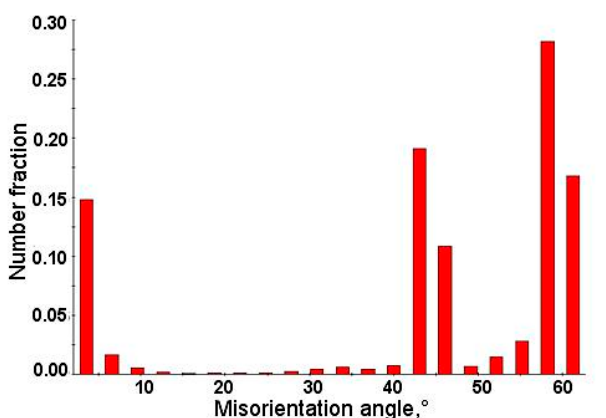
Figure 2. Electron backscatter diffraction (EBSD) analyses of the steel in the initial state. Image quality (IQ) map ( a ), phase distribution map—retained austenite (RA) as green ( b ), orientation map ( c ), map displaying the boundary character between γ and α grains ( d ).